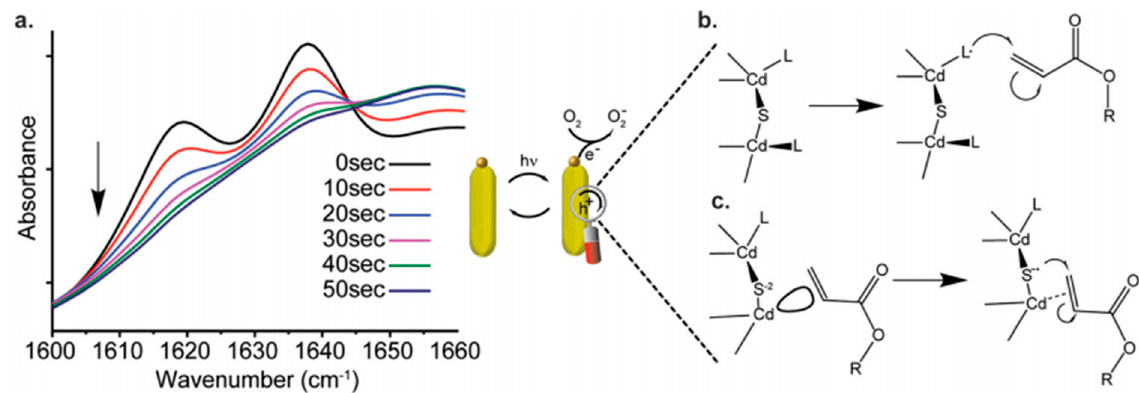
Figure 1. Insights into the mechanism. ( a ) FTIR spectra of the polymerization process of hydroxyethyl acrylate (HEA) using CdS-S 2 − in the presence of water. The C=C doublet at 1619 cm − 1 and 1637 cm − 1 disappears with illumination time. ( b ) Proposed Mechanism 1: the initiation is carried out by hole transfer from the semiconductor to the monomers via surface coating mediation. ( c ) Proposed Mechanism 2: the double bond is coordinated by the cation, followed by a hole transfer from the anion-localized state [10].